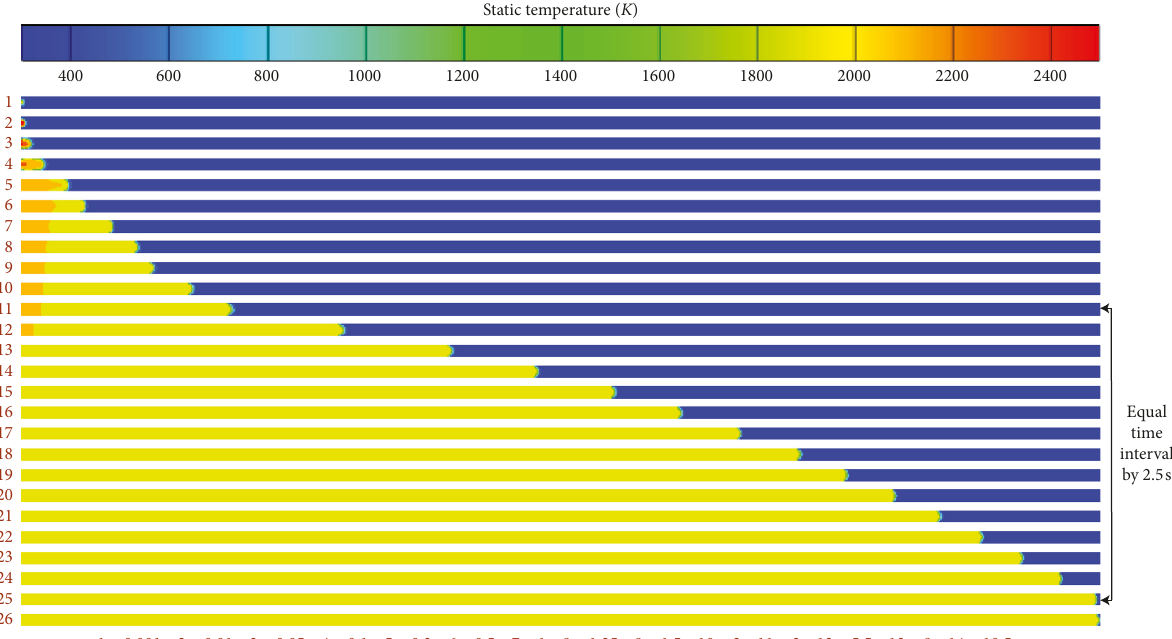
Figure 4: Flame propagation process of deflagration upon static temperature in the pipeline.